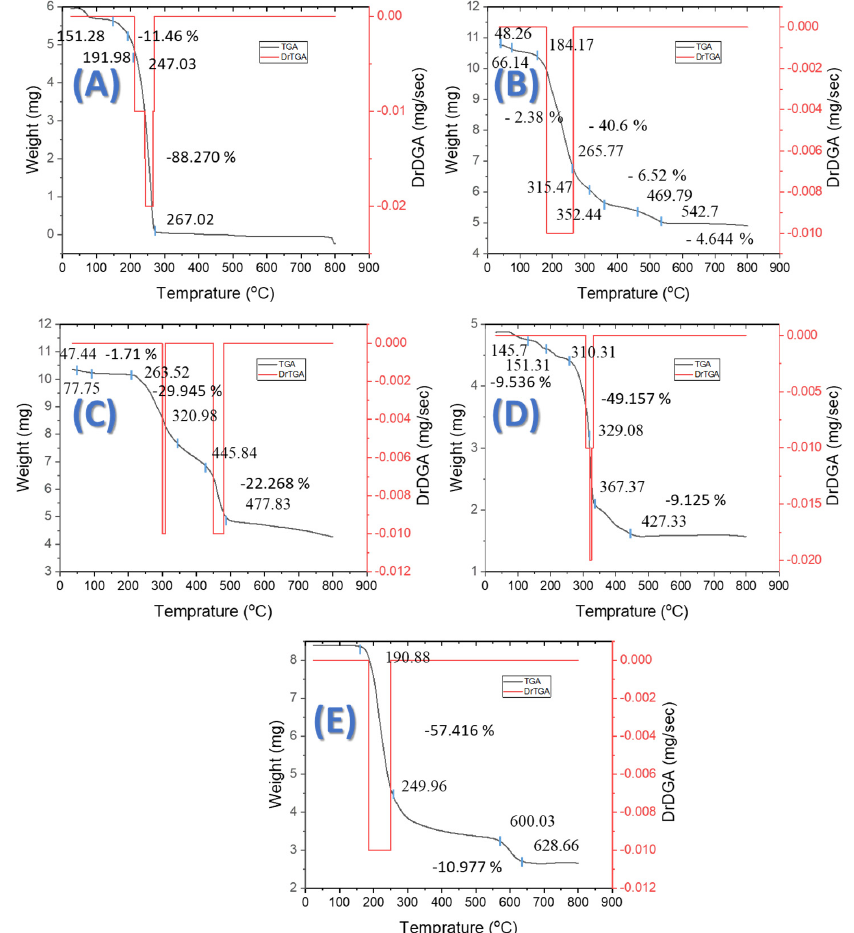
Figure 4. The TGA of the free ligand secnidazole ( A ) [Au(sec) 2 Cl]; ( B ) [Pt(sec) 2 ]; ( C ) [Pd(sec) 2 ]; ( D ) and [Ag(sec)]; ( E ) complexes.